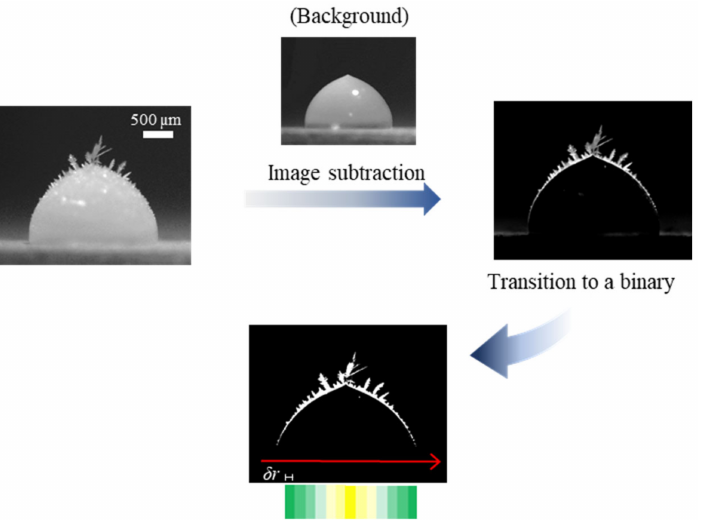
Figure 4. An example showing how the amount of deposition atop a single frozen drop is calculated from direct experimental captures using a MATLAB-based image processing